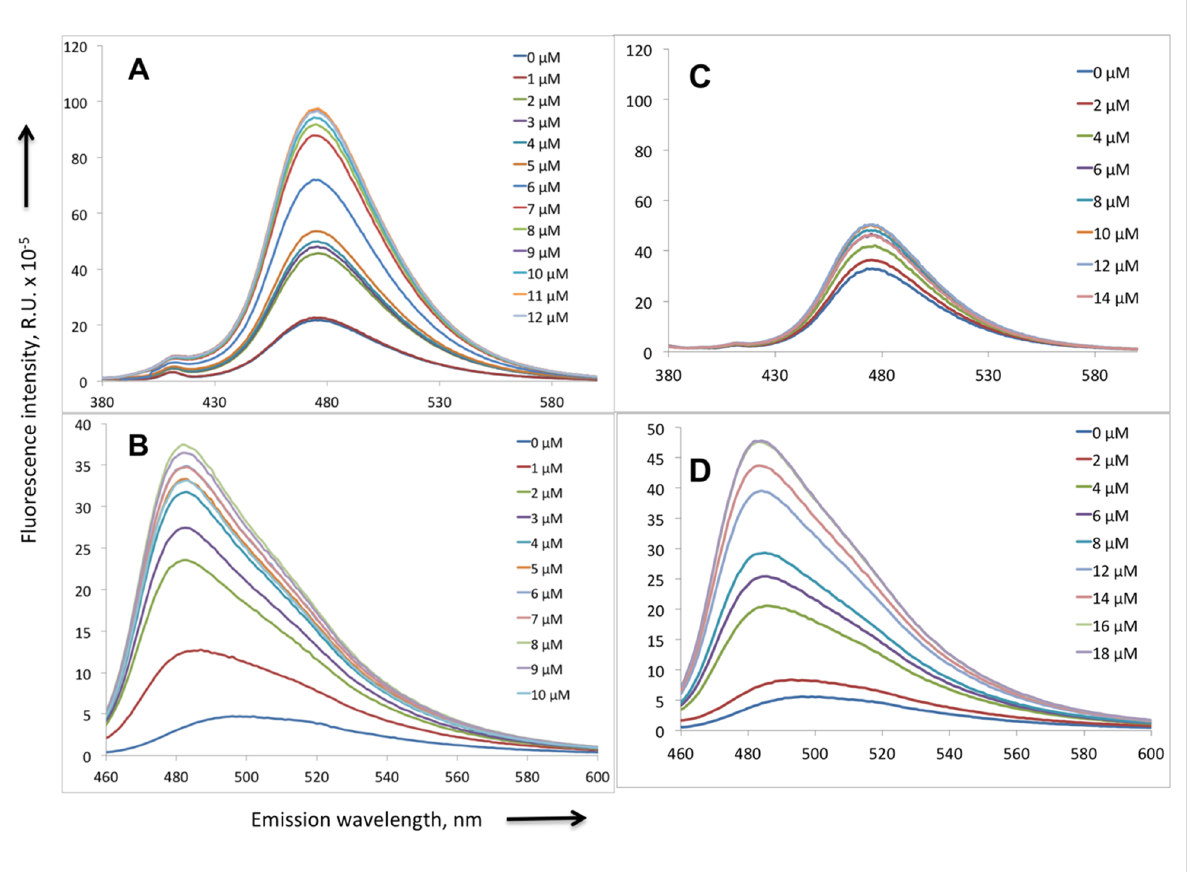
Figure 8: Titration of the probes F1-NH 2 -MM14 (12 µM, A, C) and F1-NH 2 -TO (10 µM, B, D) by the target DNA duplex (left) and non-cognate duplex (right) in 0.025 M tris-HCl, pH 7.5, at room temperature. The sequence of the target duplex is depicted in Figure 5A, the sequence of the non-cognate duplex is 5'-GGGTGAGGAGGAGGGAGATCGGTC-3'/3’-CCCACTCCTCCTCCCTCTAGCCAGT-5'. DNA concentration after each addition is indicat- ed on the right panel of each picture.